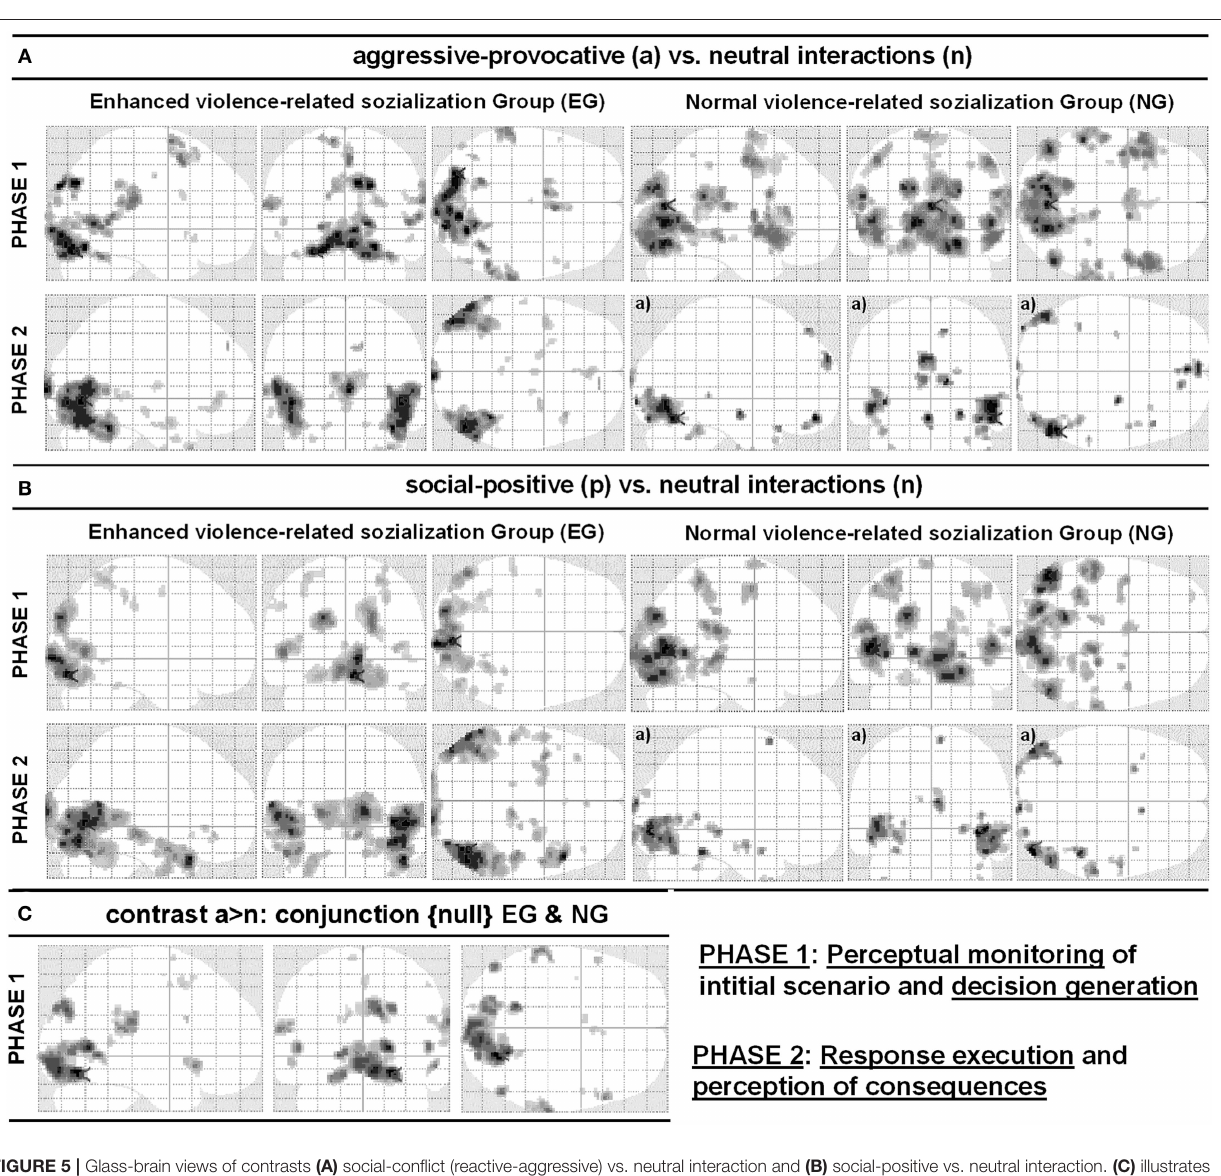
FIGURE 5 | Glass-brain views of contrasts (A) social-conflict (reactive-aggressive) vs. neutral interaction and (B) social-positive vs. neutral interaction. (C) illustrates the respective conjunction {null} analyses including both groups (EG and NG), for the contrast social-aggressive-provocative (reactive-aggressive) versus neutral interaction for PHASE I video clips. The left part of the panels shows the results for the participant group with enhanced violence-related socialization (EG) and the right part of the panels shows results for the participant group with normal violence-related socialization (NG). Anatomical regions, peak activation t-values, and Talairach-coordinates are listed in Tables 2 – 4 . All contrasts were p < 0.05, false discovery rate (FDR)-corrected, with a minimum cluster size of k = 5 voxels, except a) : p < 0.001,